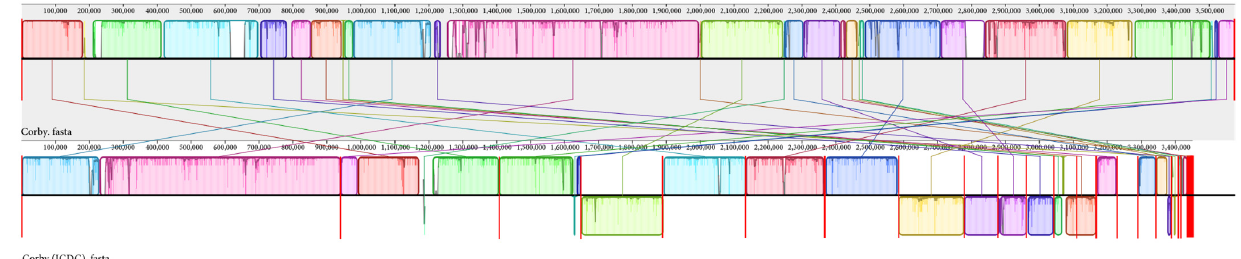
Figure 5. Comparison of the linear organization of Legionella pneumophila genomes. Local collinear blocks (LCBs) representing regions of sequence alignment are shown as coloured rectangles connected by straight lines. The LCBs placed above the line are in the same direction as the reference sequence; LCBs placed below the line are oriented in the opposite direction. Empty sections are regions of low sequence conservation.